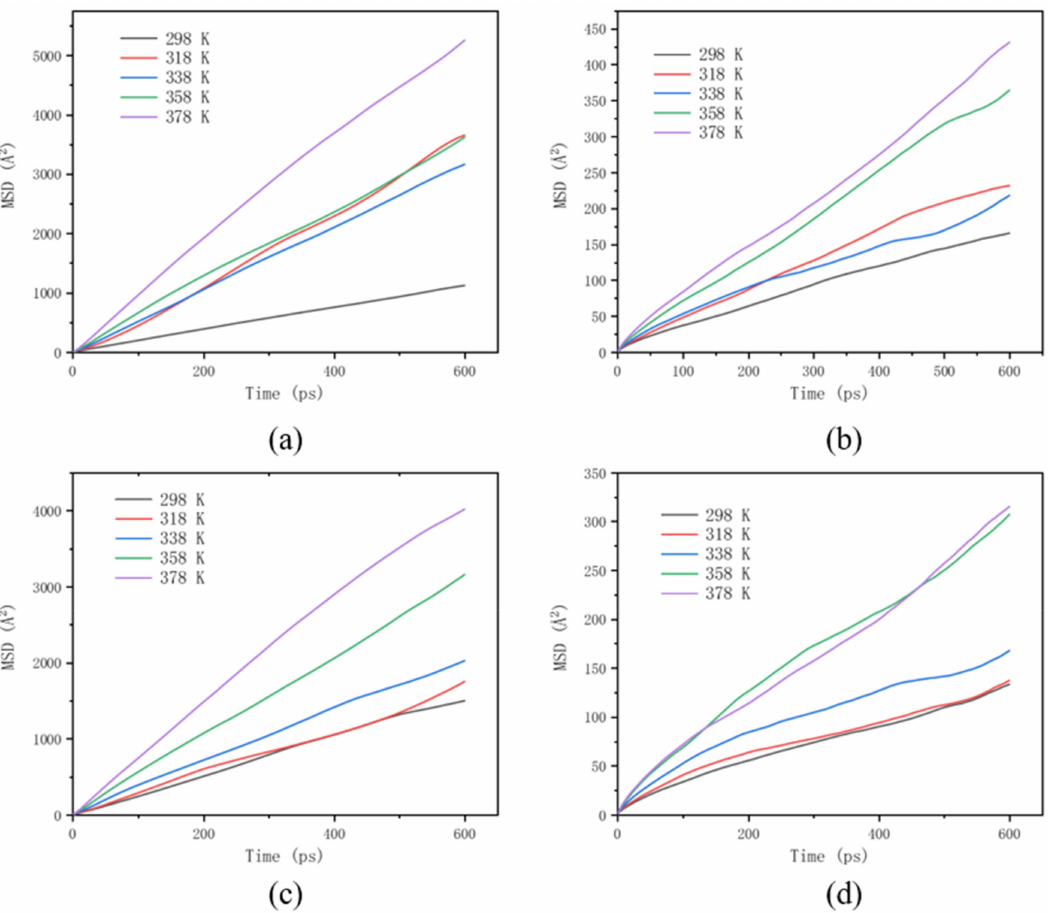
Figure 11. The changes of MSD of DMSO and β -HMX with time in the crystallization system with or without PVA at different temperatures. ( a ) DMSO–MSD (with no polymer), ( b ) HMX–MSD (with no